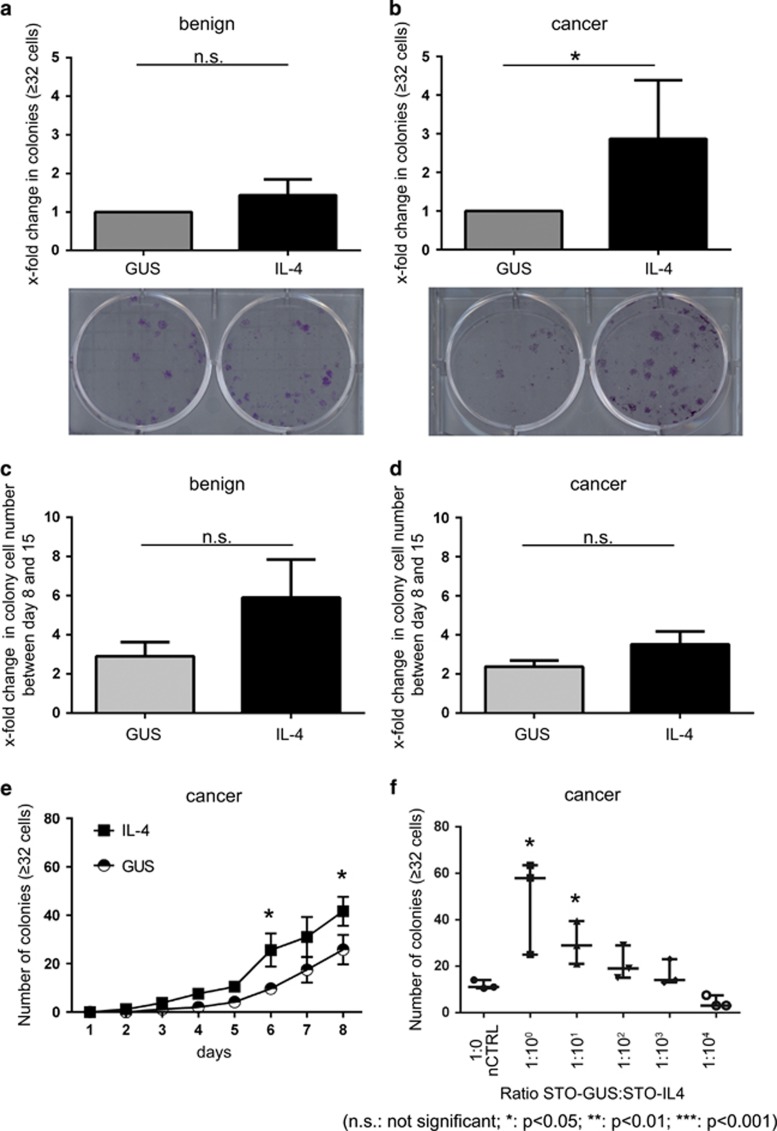
IL-4 increases clonogenic potential of primary PCa cells. (a) Clonogenic assays of benign primary prostate cells (n=4) co-cultured with STO-GUS or STO-IL-4 feeder cells. The number of colonies (⩾32 cells) was scored 15 days after plating. The results are expressed as fold change in the number of colonies and are normalised to the STO-GUS control. A representative crystal violet staining is shown at day 15. Data are shown as mean±s.d. (*P<0.05). (b) Clonogenic assays of malignant primary prostate cells (n=4) co-cultured with STO-GUS or STO-IL-4 feeder cells. The number of colonies (>32 cells) was scored 15 days after plating. The results are expressed as fold change in the number of colonies and are normalised to the STO-GUS control. A representative crystal violet staining is shown at day 15. Data are shown as mean±s.d. (*P<0.05). (c) Average colony growth of benign primary prostate cells (n=3) co-cultured with STO-GUS or STO-IL-4 feeder cells. Cell numbers from two colonies from each condition were counted at day 8 and 15, and the increase in cell number of one colony expressed as fold change. Data are shown as mean±s.d. (d) Average colony growth of malignant primary prostate cells (n=3) co-cultured with STO-GUS or STO-IL-4 feeder cells. Cell numbers from two colonies from each well were counted at day 8 and 15 and the colony growth expressed as fold change. Data are shown as mean±s.d. (e) Time course of colony formation (⩾32 cells) in primary PCa cell cultures (n=3) co-cultured with STO-IL-4 or STO-GUS for 8 days. The results are expressed as total number of colonies. Data are shown as mean±s.e.m. (*P<0.05). (f) Clonogenic assay of primary PCa cells (n=3) co-cultured with a combination of STO-GUS and STO-IL-4 feeder cells in different ratios (1:1–1:10 000). The number of colonies (⩾32 cells) was scored 15 days after plating. The results are expressed as total number of colonies. Data are shown as mean±s.e.m. (*P<0.05). NS, not significant.